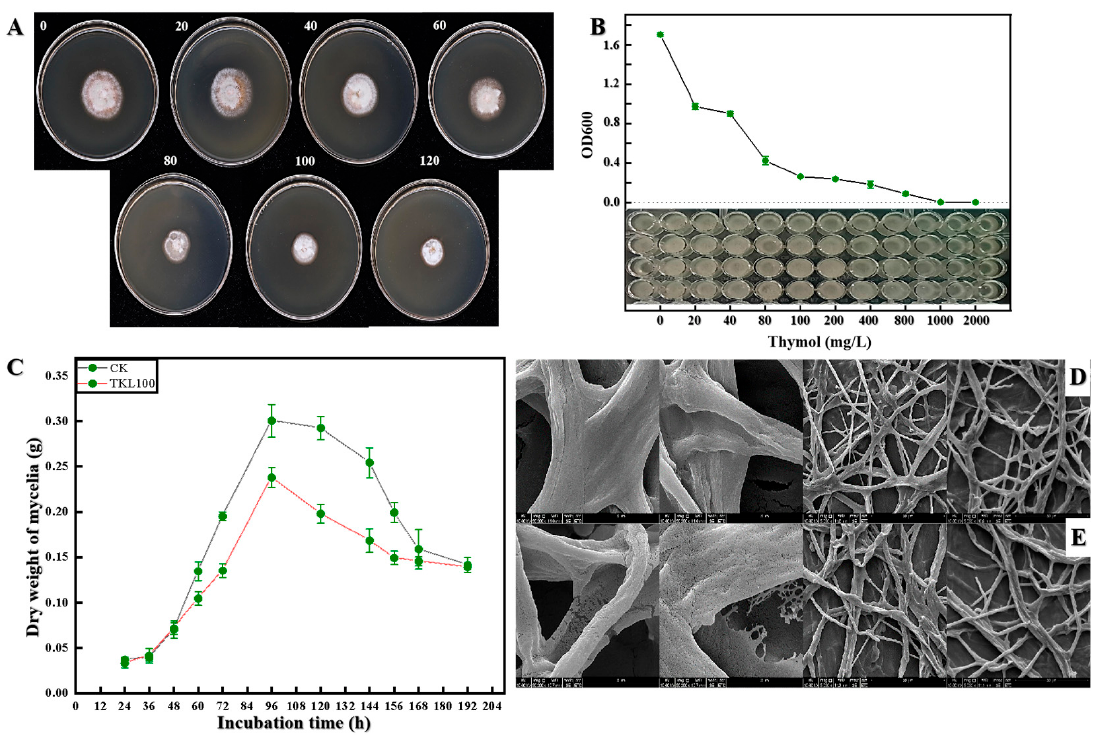
Figure 4. Colony growth after TKL treatment with different thymol concentrations, such as TKL 100 as a thymol edible coating with a thymol concentration of 100 mg/L. ( A ); determination of minimum inhibitory concentration (MIC) of TKL on the growth of pathogenic fungus ( B ); changes in the growth cycle of C. fioriniae after TKL100 treatment ( C ); healthy hyphae of C. fioriniae ( D ); and hyphae of C. fioriniae treated with TKL100 ( E ).